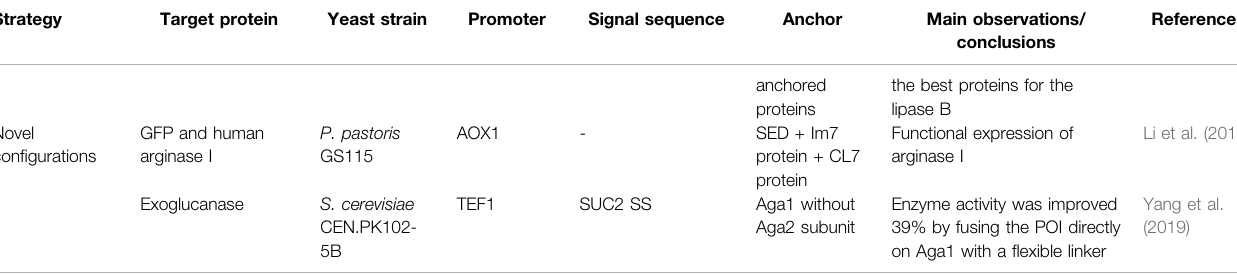
TABLE 1 | ( Continued ) Strategies focused on key factors that affect the displayed protein production.